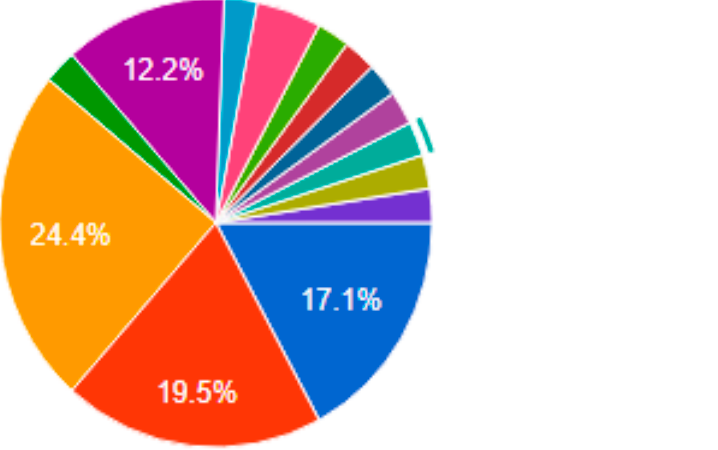
Figure 12. Result for the primary programming language of participants.